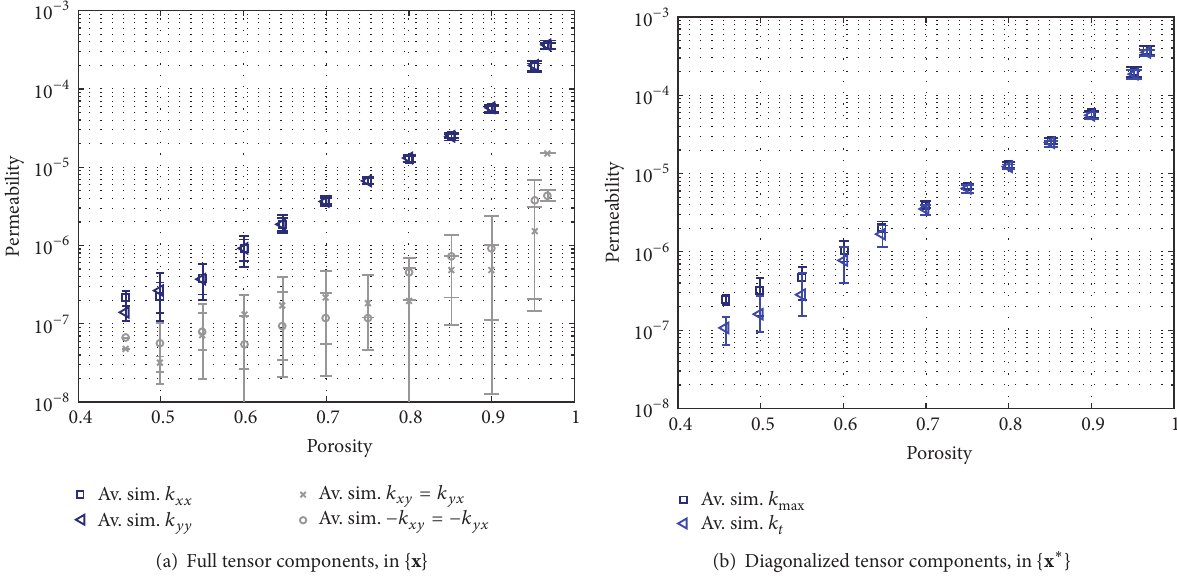
Figure 15: Permeability-porosity trend for randomly distributed squares. The full permeability tensor contains nonzero off-diagonal components (absolute values are plotted; however negative and positive quantities are indicated by different symbols) and is diagonalized to obtain the principal permeability components, 𝑘 max and 𝑘 𝑡 . { x } and { x ∗ } are related by rotation angle 𝜃 𝑘 , which is plotted in Figure 16(a). The anisotropic ratio of the principal components is plotted in Figure 16(b).